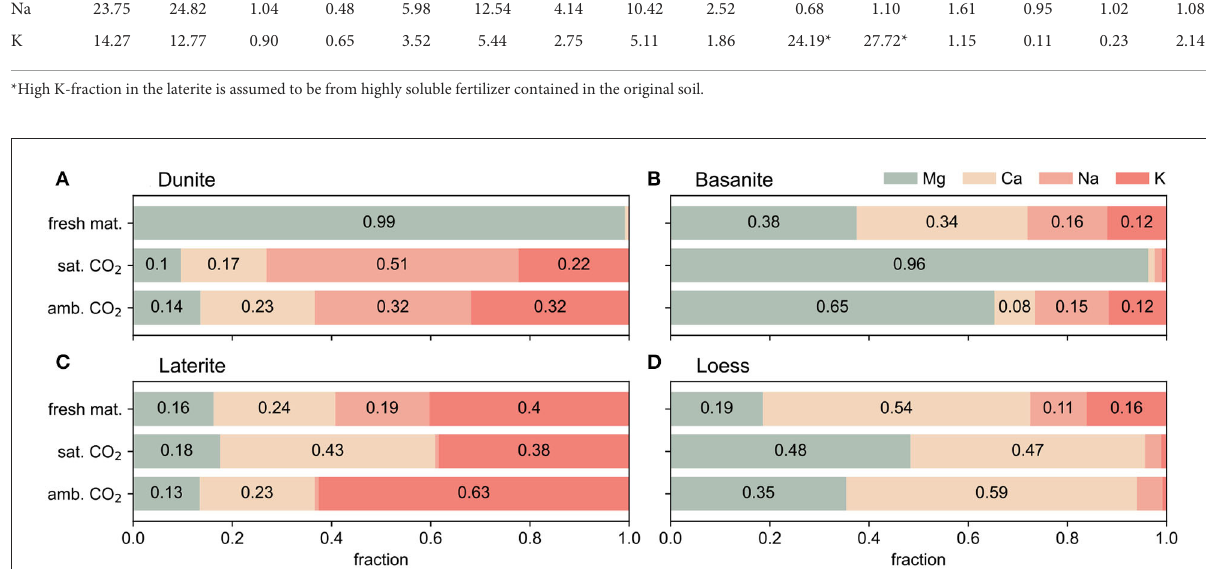
FIGURE4 Relative fractions of major cations [from left to right: Mg (green), Ca (light orange), Na (light red), K (red)] in the original, unreacted material (see XRF analyses, Table 1) and the relative cumulative fractions of each cation released over the 300-day reaction time under ambient and saturated-CO 2 conditions. (A) Dunite, (B) Basanite, (C) Laterite, (D)